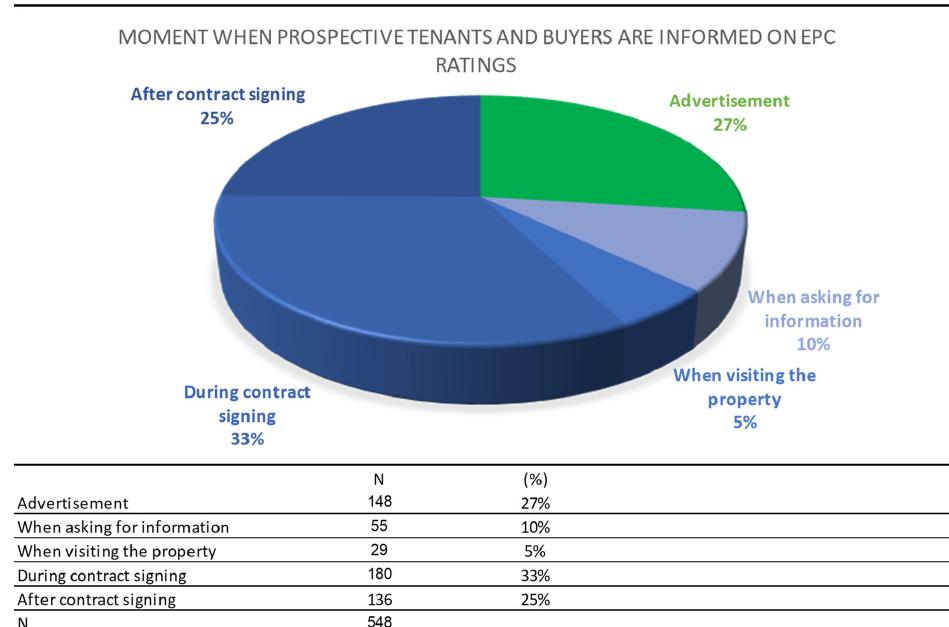
Buildings 2020 , 10 , 27 Figure 4. Moment of disclosure of EPCs in residential transactions. Figure 4. Moment of disclosure of EPCs in residential transactions.